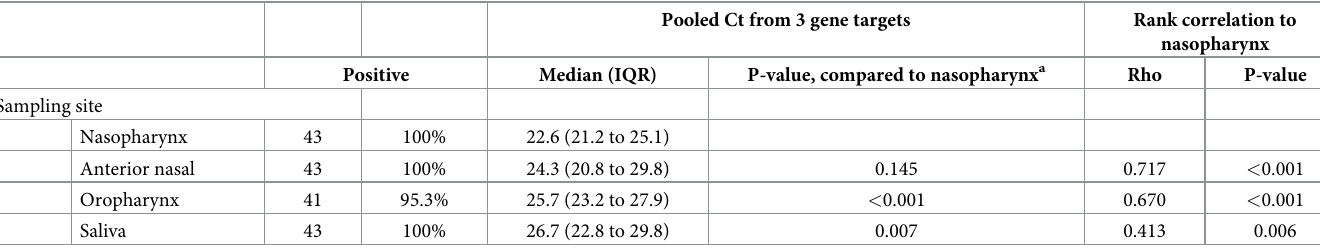
Table 1. SARS-CoV-2 RT-PCR results and correlations according to sampling site.